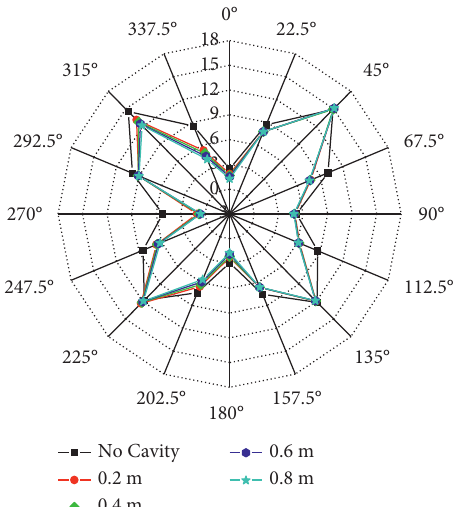
Figure 17: Coefficient of safety for each section of the segment at different depths of the cavity behind the arch